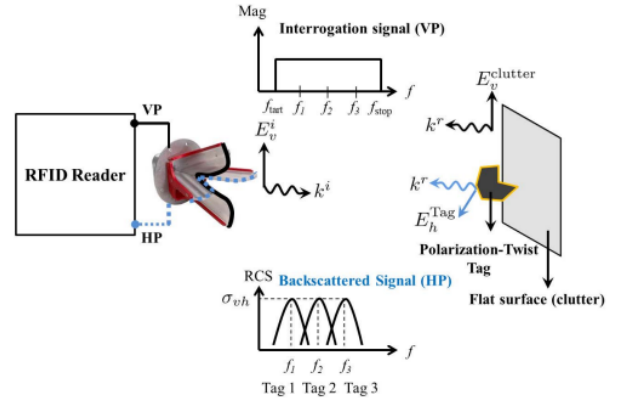
Figure 21. Operation principle of the proposed antenna [91].